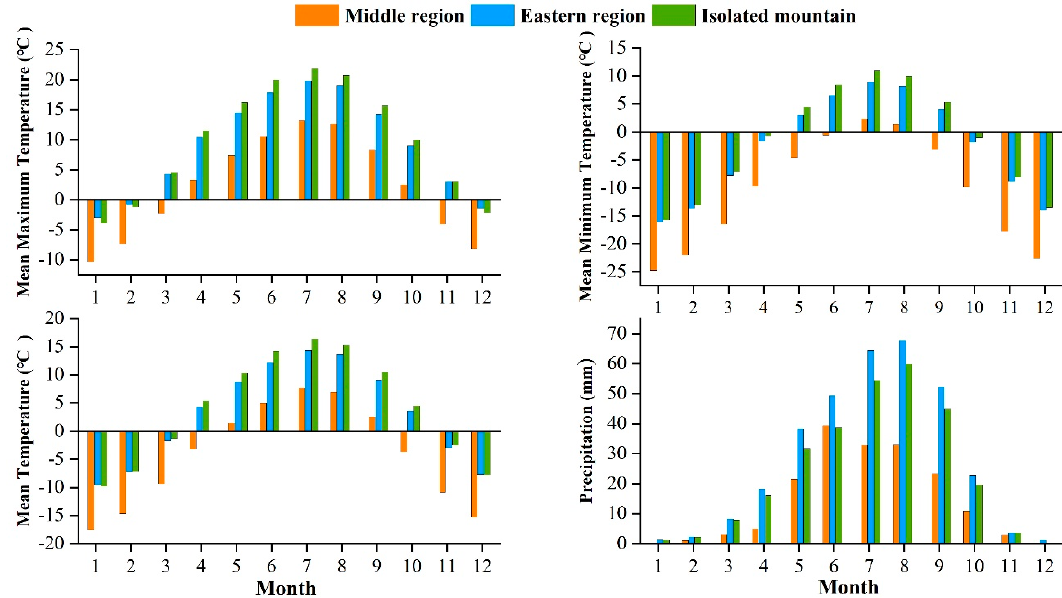
Figure 3. Monthly mean maximum, mean minimum, mean temperatures, and total precipitation, during 1957–2018 in the three Central and Eastern Qilian Mountains regions.